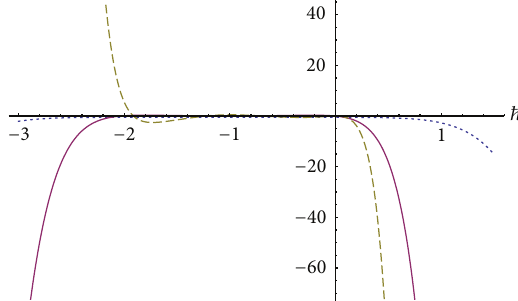
Figure 4: The ℎ -curves according to 9th-order approximation. Dashedpoint: 𝑢(0.01, 0.01) ,solidline: ̇𝑢(0.01, 0.01) ,anddashedline: ̈𝑢(0.01, 0.01)